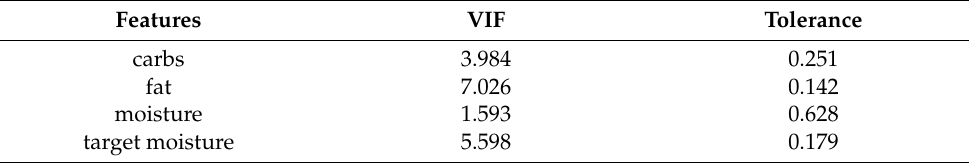
Table 4. Variance inflation factor and tolerance statistics for multicollinearity analysis.